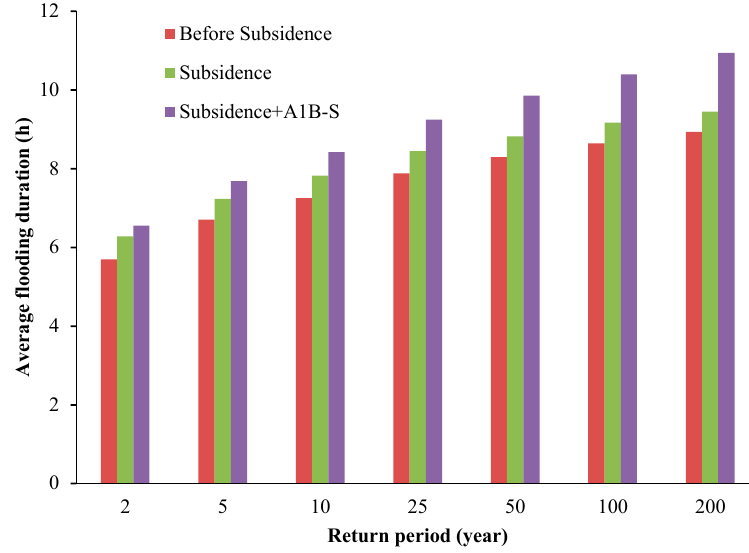
Figure 11. Average flooding duration for a one-day storm under different return periods and scenarios.